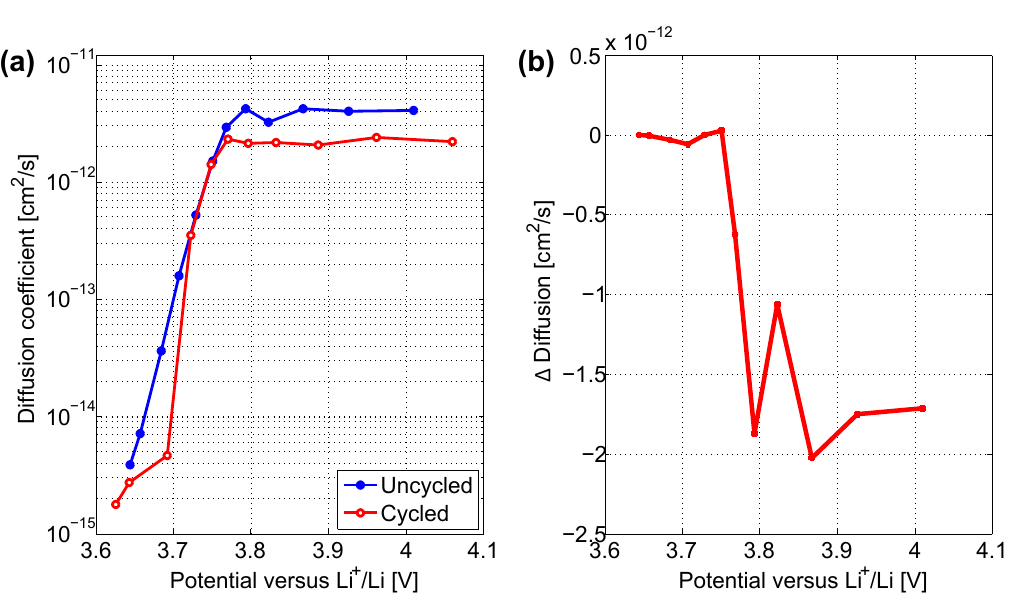
Figure 9. ( a ) Diffusion coefficient in uncycled and cycled positive electrodes determined by EIS characterisation. ( b ) Difference between cycled and uncycled electrodes.